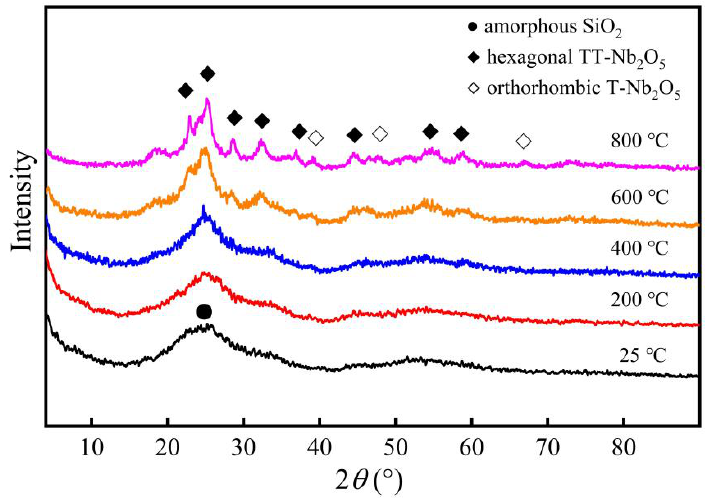
Figure 6. XRD patterns of Nb/SiO 2 materials with n Nb = 1 calcination at various temperatures. The XRD patterns of the Nb/SiO 2 materials with various n Nb calcined at 400 °C are